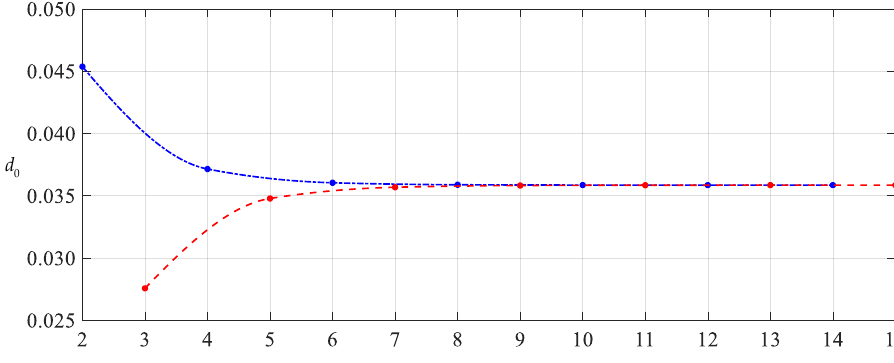
Figure 5. Variation of c 1 with n .